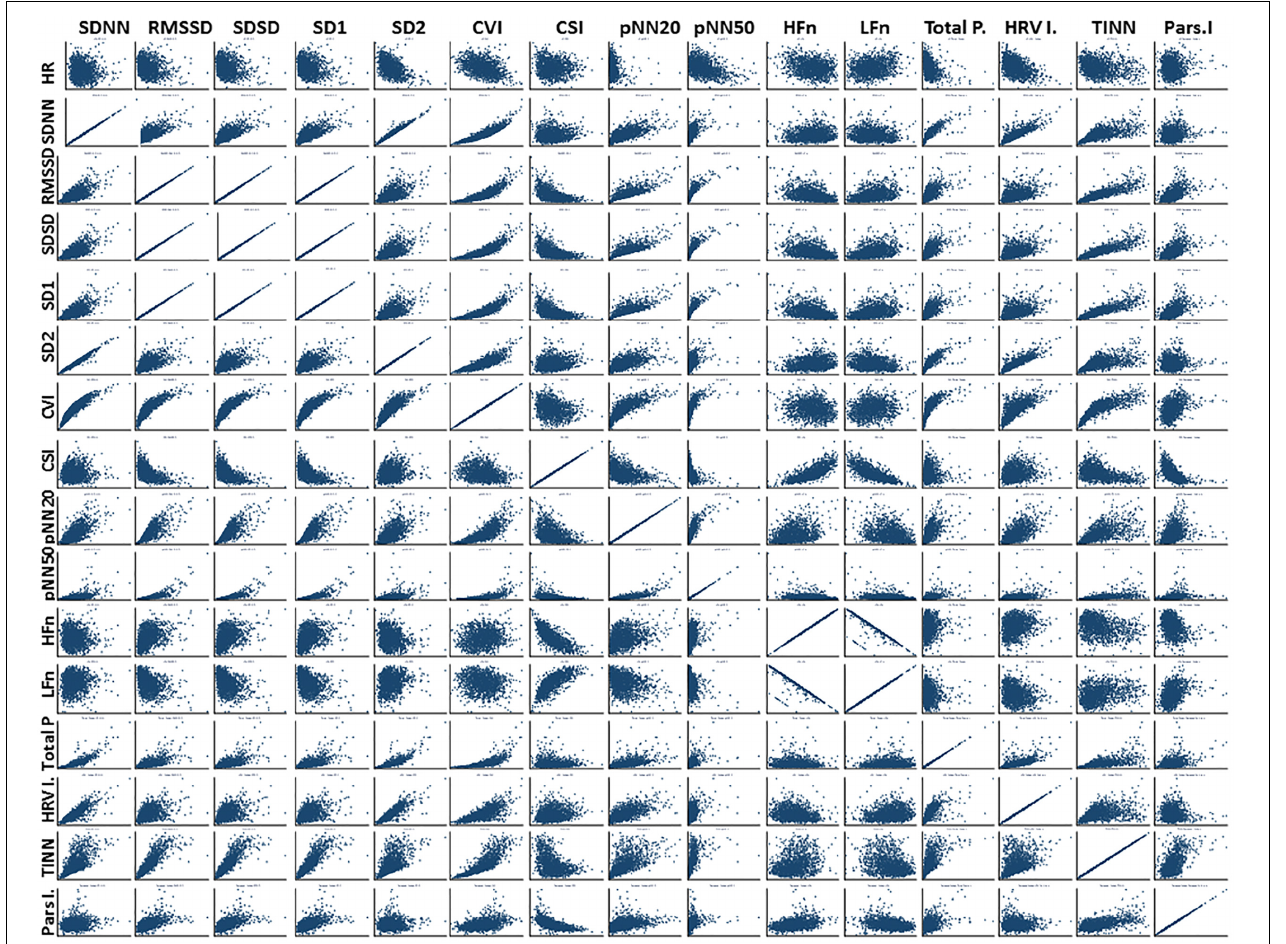
FIGURE 4 | Correlation matrix: all HRV metrics. For abbreviations of HRV metrics, please refer to Table 1 . We note particularly (a) the concordance between RMSSD, SDSD, and SD1, which has been previously described; (b) the behavior of different HRV metrics in relation to HR which highlights how much additional information HRV analysis can provide; (c) the interdependency of HFn and LFn and CVI and CSI, highlighting the interplay between sympathetic and parasympathetic